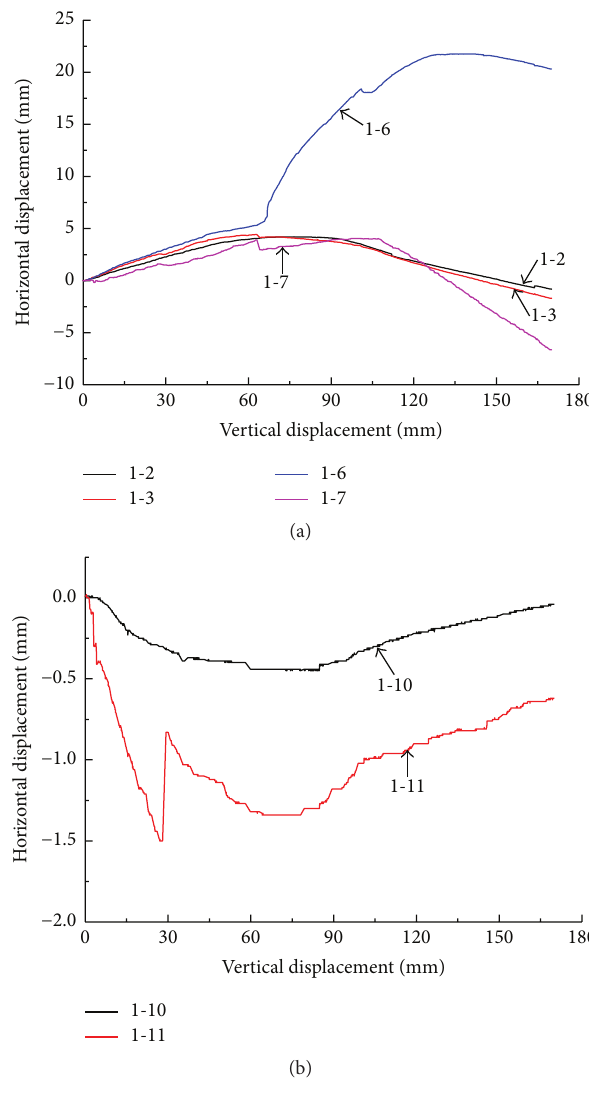
Figure 11: Relationship between the horizontal displacement and the vertical displacement of the